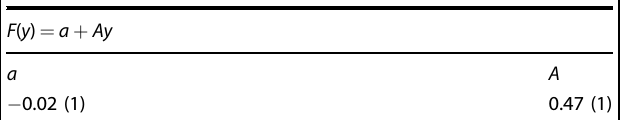
Table 4. Fit parameters for Fig. 3a.